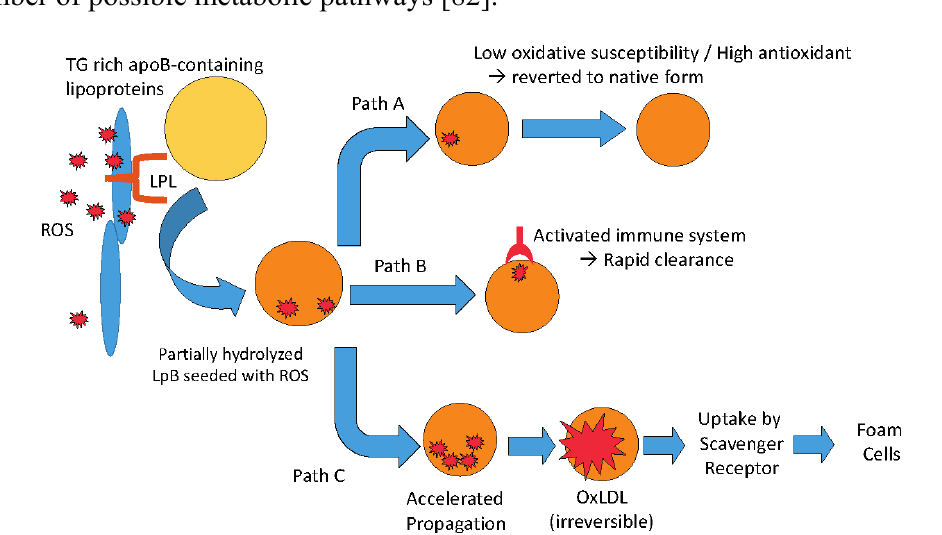
Figure 3. Possible metabolic fates of apoB-containing lipoproteins that have been seeded with reactive oxygen species (ROS) following interactions with lipoprotein lipase anchored along the arterial